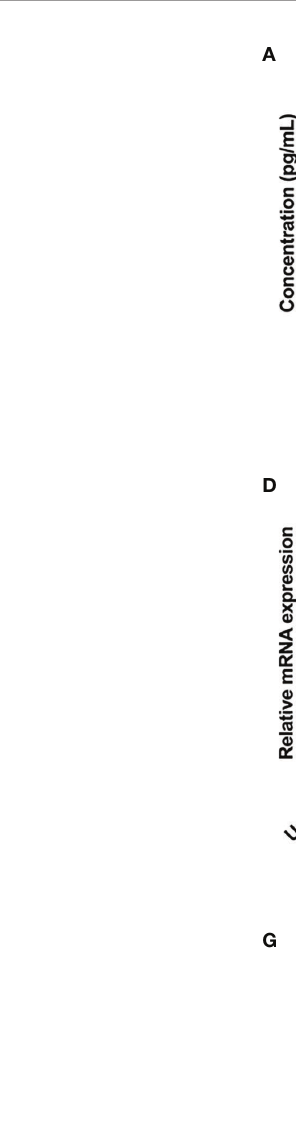
FIGURE 3 | TET NE suppresses protein levels and mRNA expressions of pro-in fl ammatory cytokines in IMQ-treated psoriatic mice. WT mice (N = 9) were treated with IMQ for 6 days. TET NE treatment starts from the second day after IMQ treatment for 5 days. 24 hours later, the mice were sacri fi ced. The serum and skin were harvested. The protein level of IFN- g (A) , TNF (B) , and IL-17A (C) in serum were measured by CBA kits. The mRNA expression of IFN- g (D) , TNF (E) , and IL-17A (F) in skin lesions was measured by RT-PCR. (G) Immuno fl uorescence staining of IL-17A in the skin sections of mice in different groups. Data were shown as means ± SEM. -: IMQ without treatment; Blank: IMQ + blank gel treatment. * P < 0.05, ** P < 0.01, *** P < 0.001, compared with IMQ